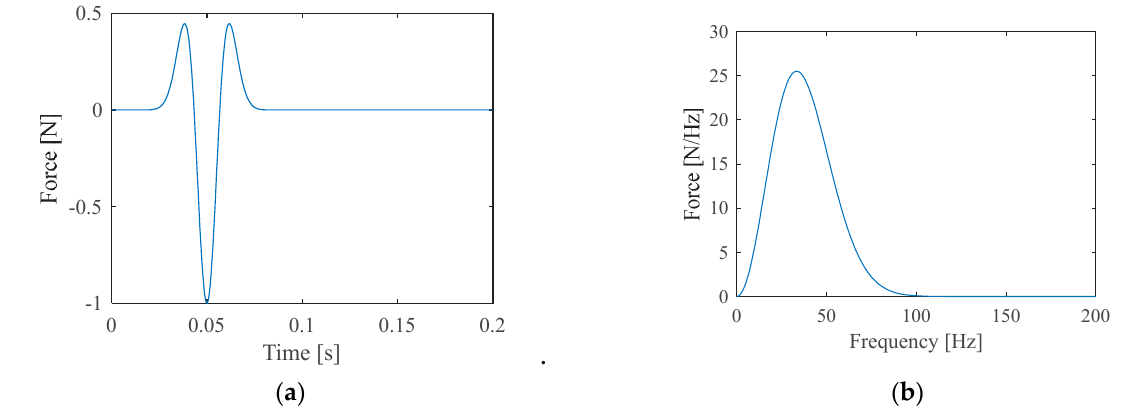
Figure 11. Ricker pulse: ( a ) time history; ( b ) frequency content.